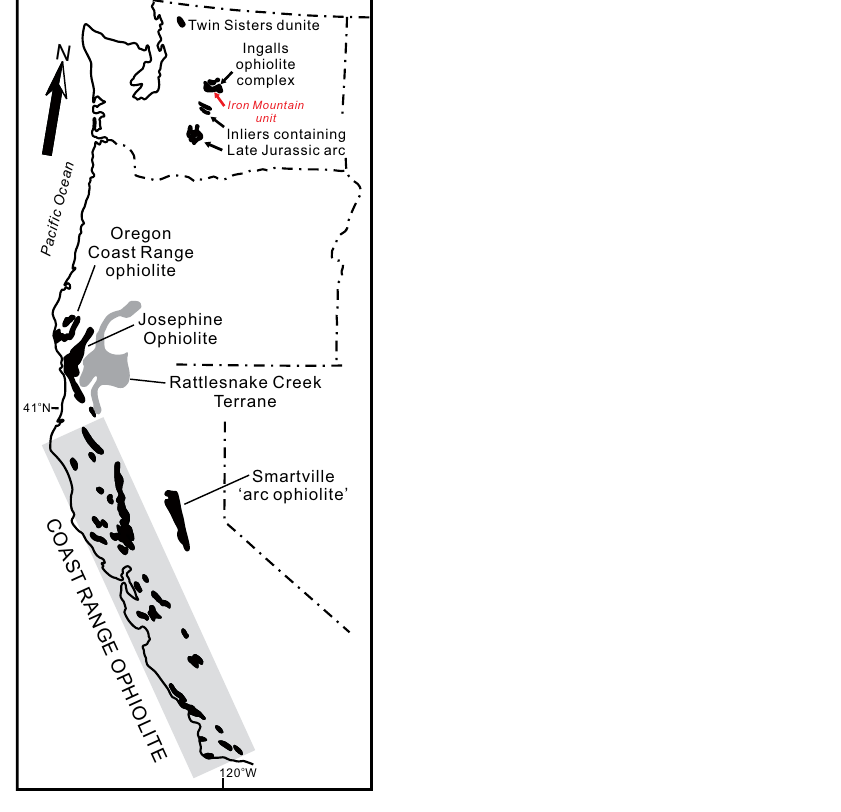
Figure 6. Distribution of Middle to Late Jurassic ophiolites of the North American Cordillera from Washington to California 118